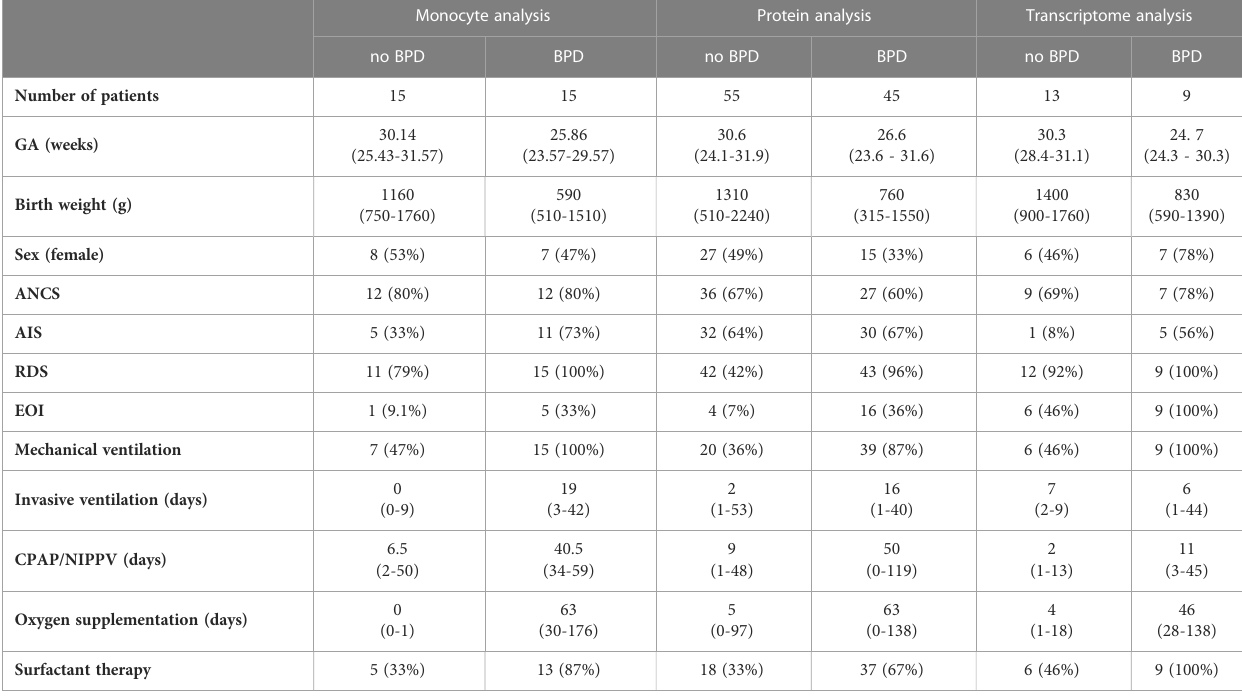
TABLE 1 Description of cohorts used for transcriptome, protein, and monocyte